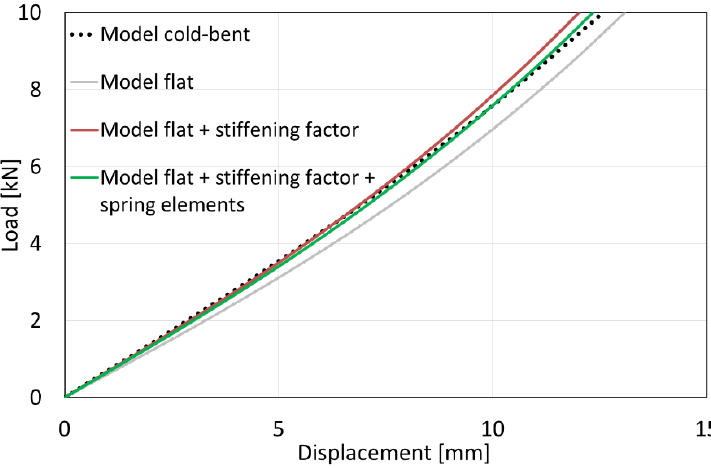
Fig. 13 Comparison of different numerical models under pressure: global